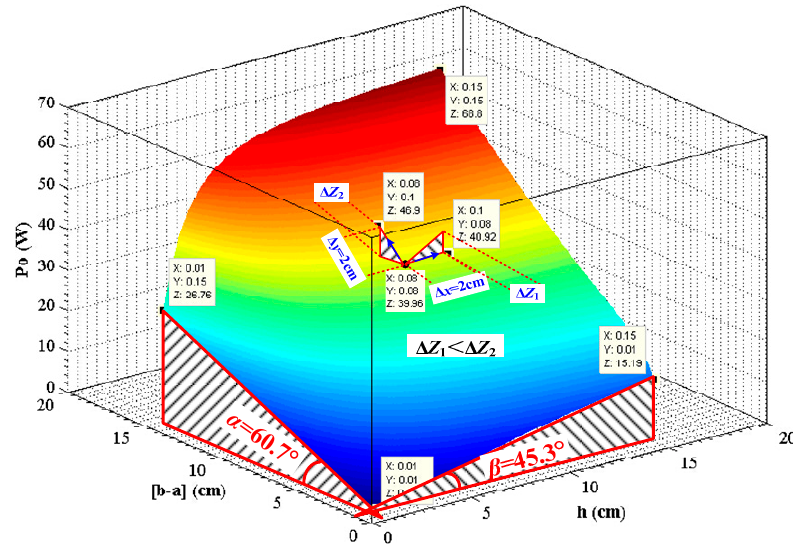
Figure 6. The relationship between the harvested energy and the thickness/axial height of the core.